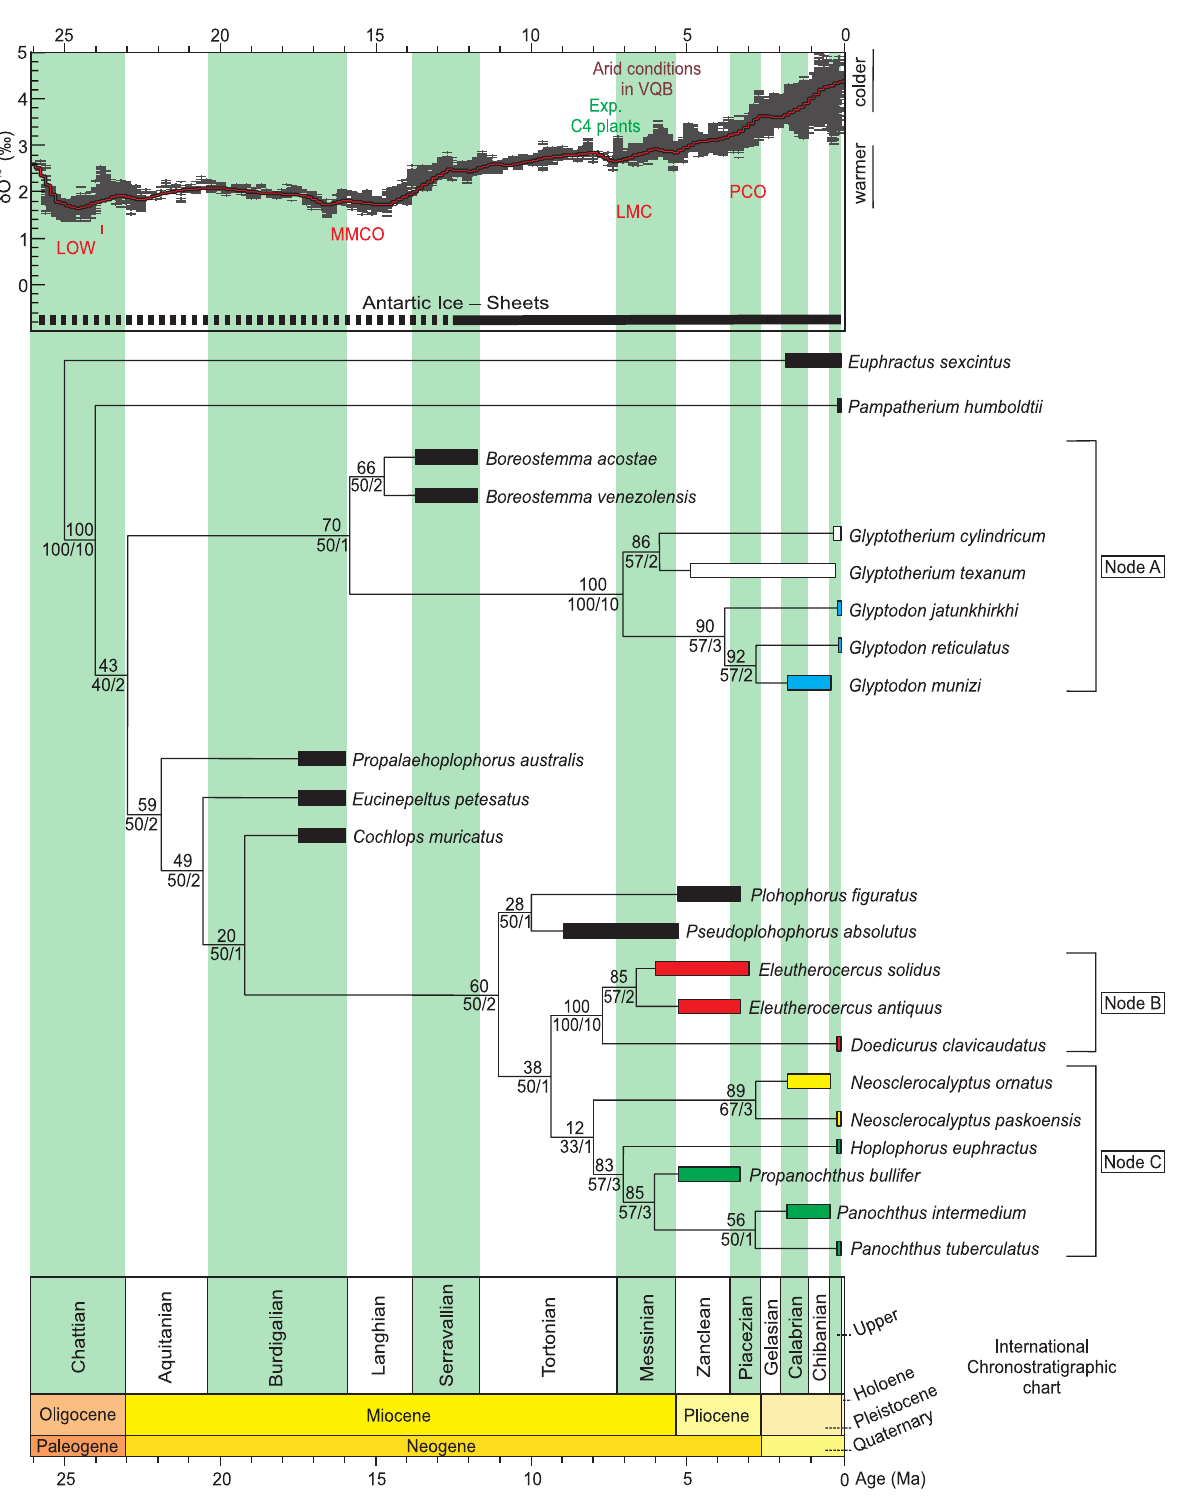
Fig. 8. Phylogeny of Glyptodontidae based on TNT parsimony analysis of 57 osteological characters from 23 taxa (tree length 97 steps; Consistency Index 0.79; Retention Index 0.91). The numbers above each node represent Jackknife values; numbers under each node show relative Bremer support (right) and absolute Bremer support (left). Node A: Glyptodontinae (taxa in white correspond to Glyptotheriini; taxa in blue correspond to Glyptodontini); Node B: Doedicurinae (taxa in red); Node C: Hoplophorinae (taxa in yellow correspond to Neosclerocalyptini; taxa in green correspond to Hoplophorini). Chronostratigraphic calibration of the phylogenetic relationships of Neogene Glyptodontidae is compared to benthic foraminifera δ 18 O values from Zachos et al. (2001) to visualize the evolution of the Doedicurinae clade in the context of paleoenvironment and climate changes throughout the Neogene in north-western Argentina. Abbreviations: LOW, Late Oligocene Warming; MMCO, Middle Miocene Climatic Optimun; LMC, Late Miocene Cooling; PCO, Pliocene Climatic Optimun; Exp. C4 plants, expansion of C4 plants; VQB, Villavil-Quillay